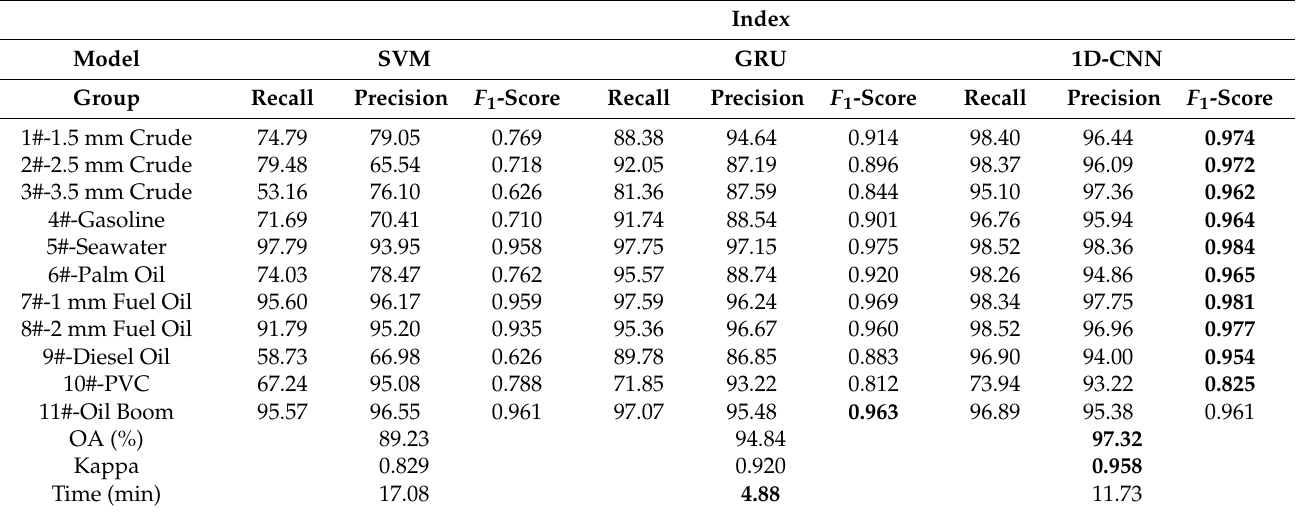
Table 7. Accuracy of the detection results at